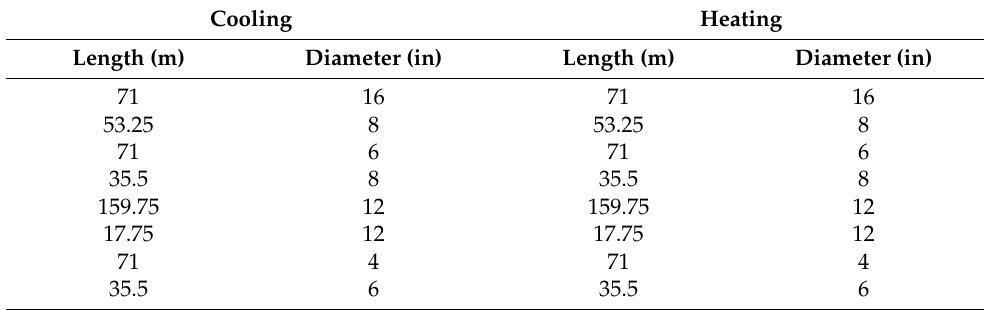
Table 6. Pipe sizing